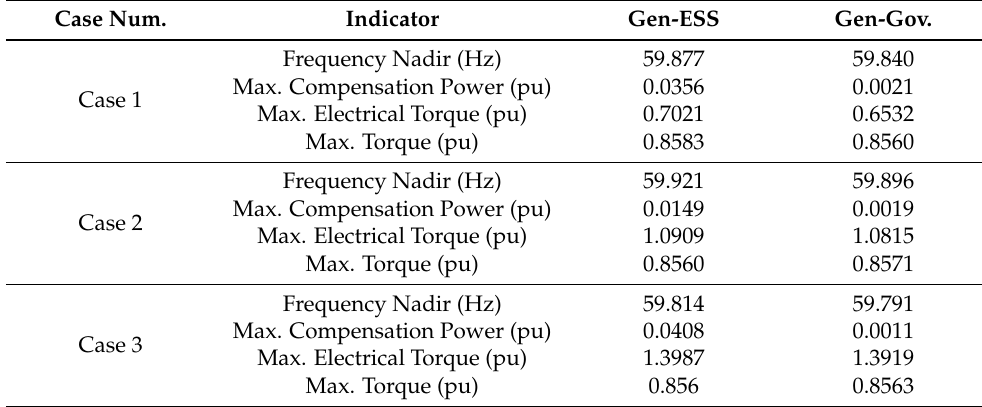
Table 3. Results from case studies. Case